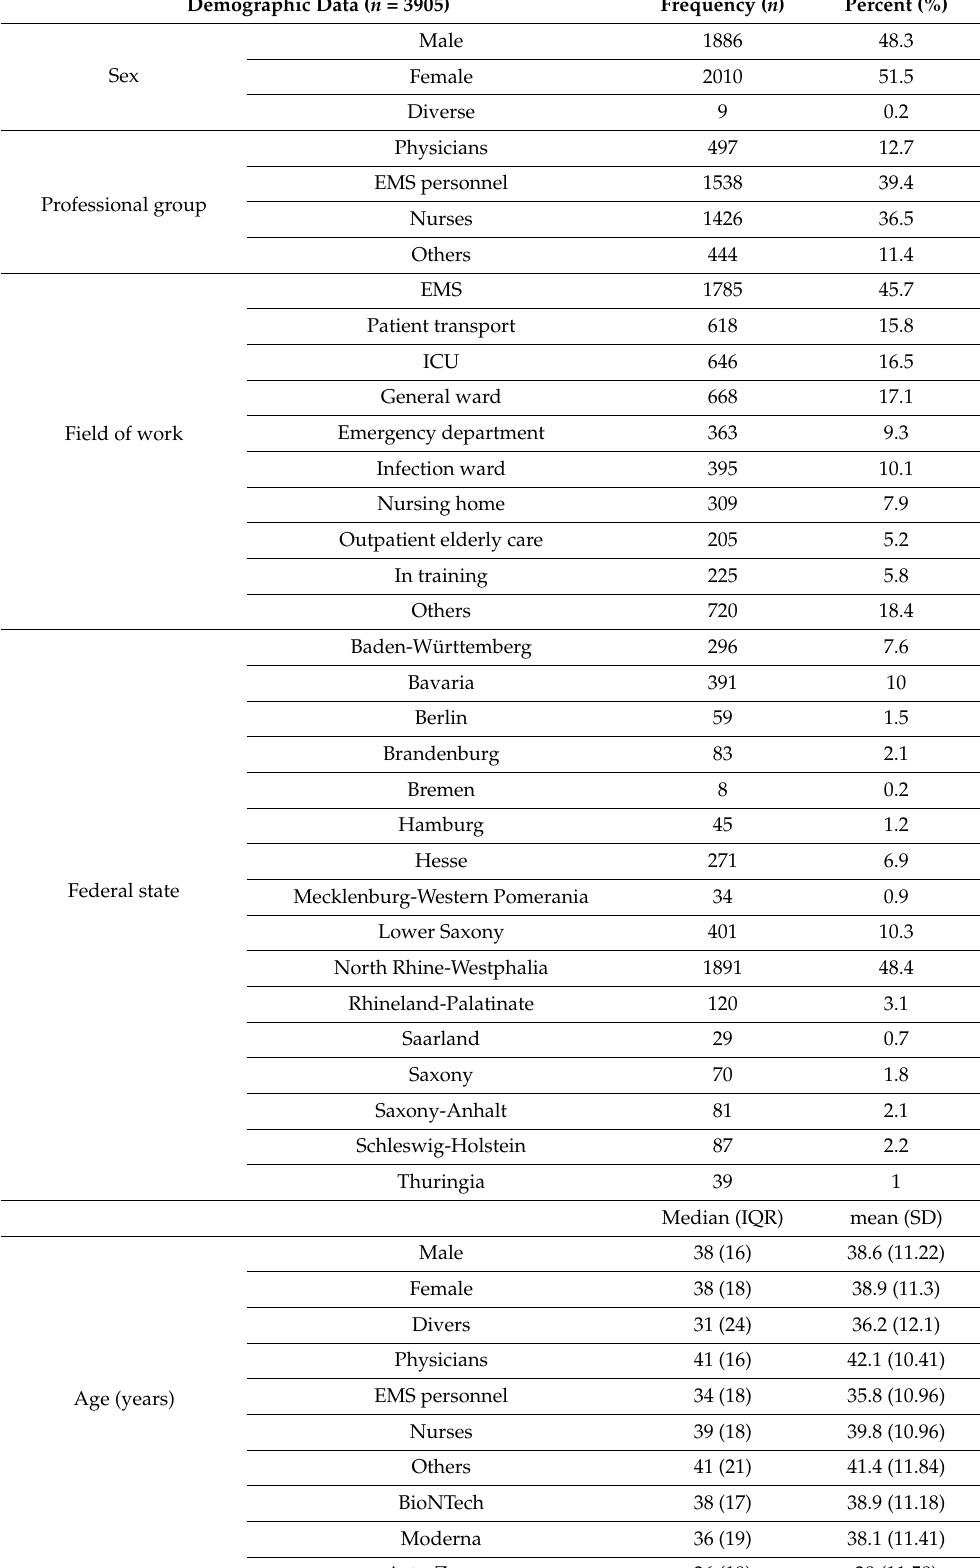
Table 1. Demographic data of 3905 frontline health care workers in Germany, 23 February–29 March